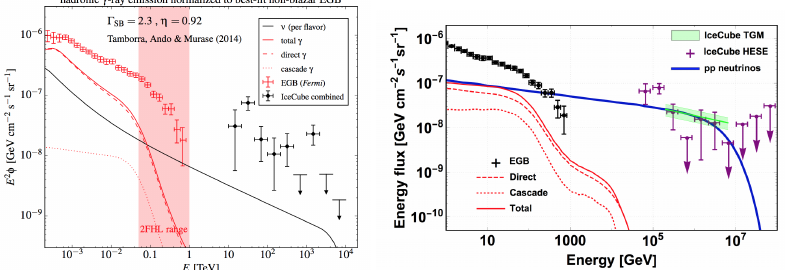
Figure 13. Multimessenger comparison between the flux of astrophysical neutrinos and the associated flux of γ -rays. In the left panel, High Energy Starting Events for the neutrino flux are used (figure from Reference [112]). In the right panel through-going muons are used (figure from Reference